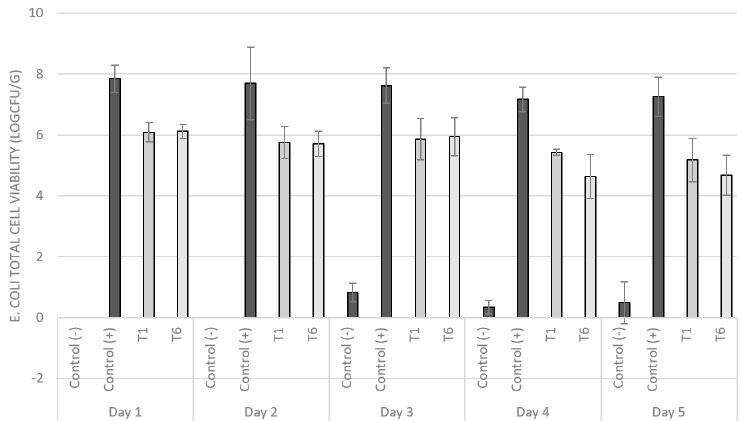
Figure 4. Viability of E. coli strains in pineapple slices treated with peptide-based formulation. Legend: Control (−): fruit slices, no pathogens, no peptide; Control (+): fruit slices+ indicator cocktail; T1: fruit slices treated with indicator cocktail + formulation T1 (CFS); T6: fruit slices treated with indicator cocktail + formulation T6 (PP); T1: Cys5-4CFS + Gt28CFS:1:1 v / v ; T6: Cys5-4PP + Gt28PP:1:1 v / v .